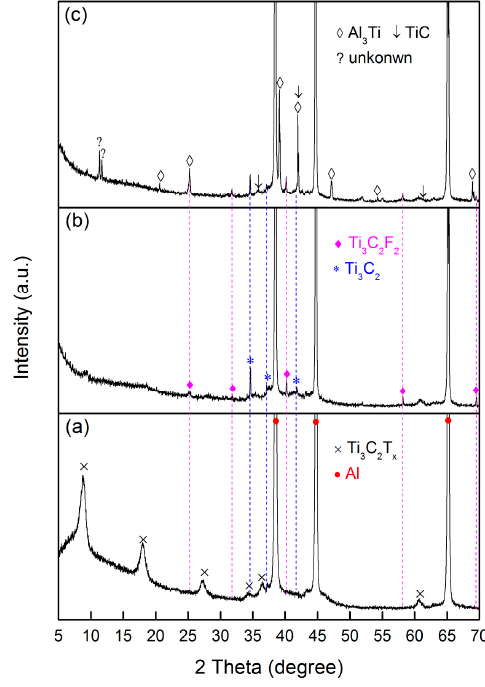
Figure 2. XRD patterns of the Ti 3 C 2 /Al mixture before ( a ), and after heat treatment at ( b ) 650 °C and ( c ) 700 °C in Ar for 1 h.